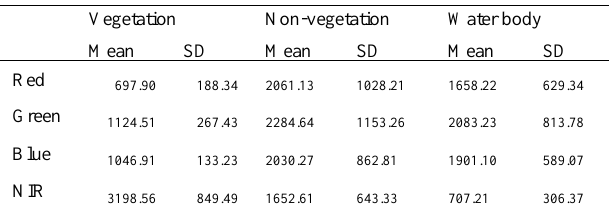
Table 4. Summary of descriptive statistics of DN values of non- shadow area